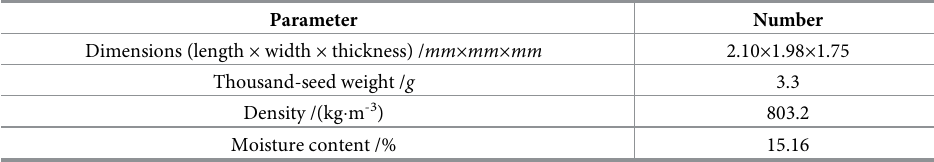
Table 1. Basic physical properties of Chinese cabbage seeds.